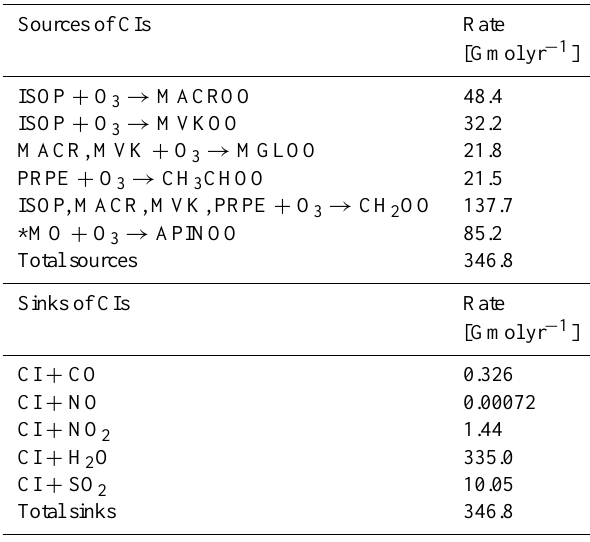
Table 1. Overview of the GEOS-Chem-TOMAS simulations per- formed in this study.